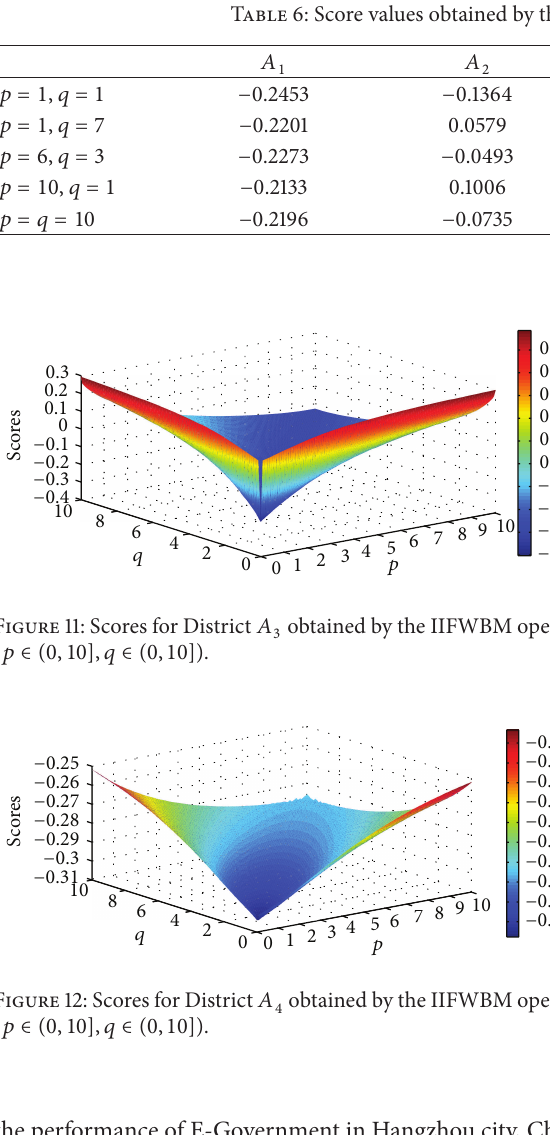
the performance of E-Government in Hangzhou city,